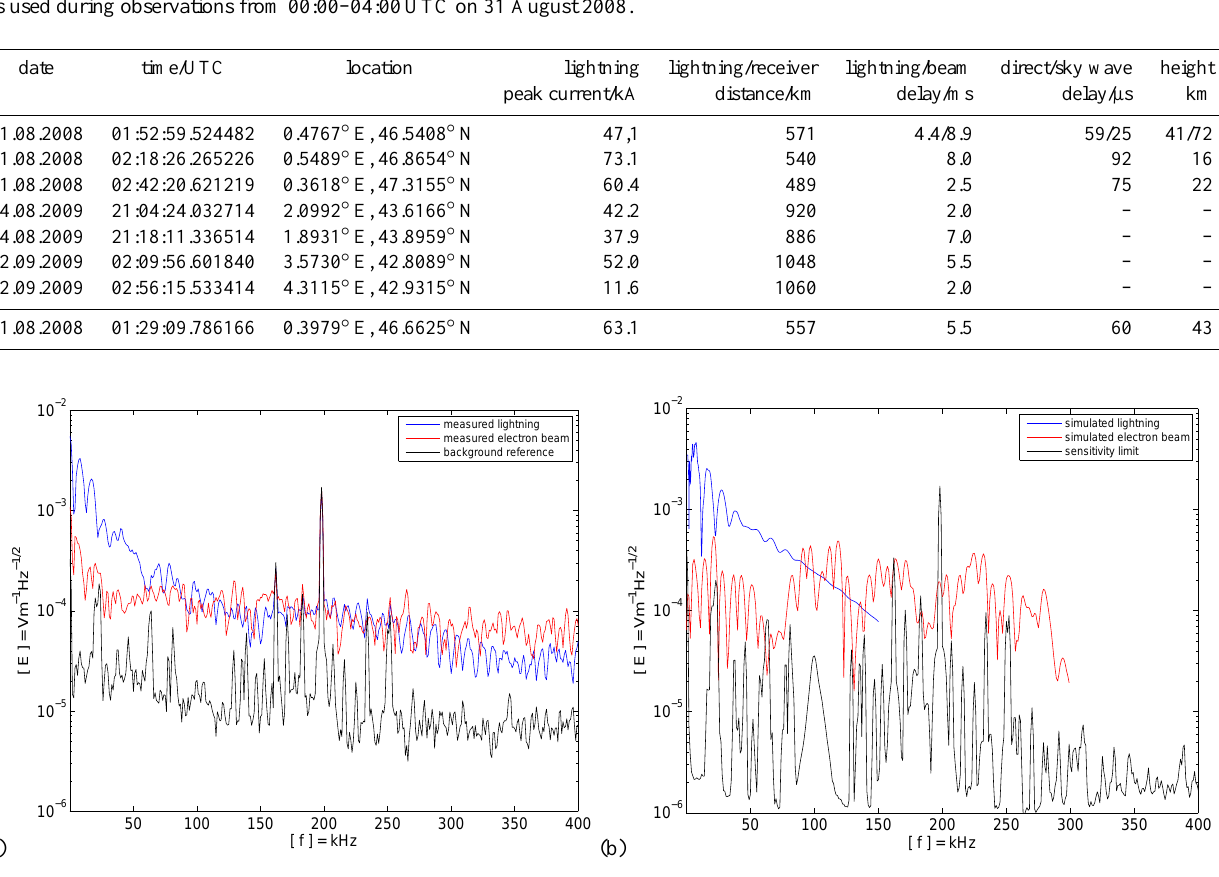
Fig. 4. The average spectra of radiation from electron beams (red lines) and their causative lightning discharges (blue lines) on the left compare well with the theoretical simulations on the right. (a) : The average spectrum of radiation produced by the seven measured electron beams (Table 1) is relatively flat at frequencies < 40kHz (red line) when compared with the average spectrum of their causative lightning discharges (blue line). The lightning and electron beam spectra are ∼ 1–2 orders of magnitude larger than the average background spectrum (black line) which is recorded 10ms prior to the causative lightning discharges for reference. (b) : The radiation from the simulated electron beam is relatively flat at frequencies < 40kHz (red line) when compared with the simulated spectrum of the causative lightning discharge (blue line). The simulated spectra are ∼ 2–3 orders of magnitude larger than the sensitivity limit of the wideband digital radio receiver ∼ 1–2µVm − 1 Hz − 1 / 2 which is inferred from time intervals without any bursts of electromagnetic radiation (black line). Superimposed on this ultimate reference spectrum are the omni-present low frequency, or long wave, radio transmitters, the strongest of which is here the BBC Radio 4 transmitter at 198kHz, which exhibits spectral amplitudes comparable to the measured and simulated electron beam.